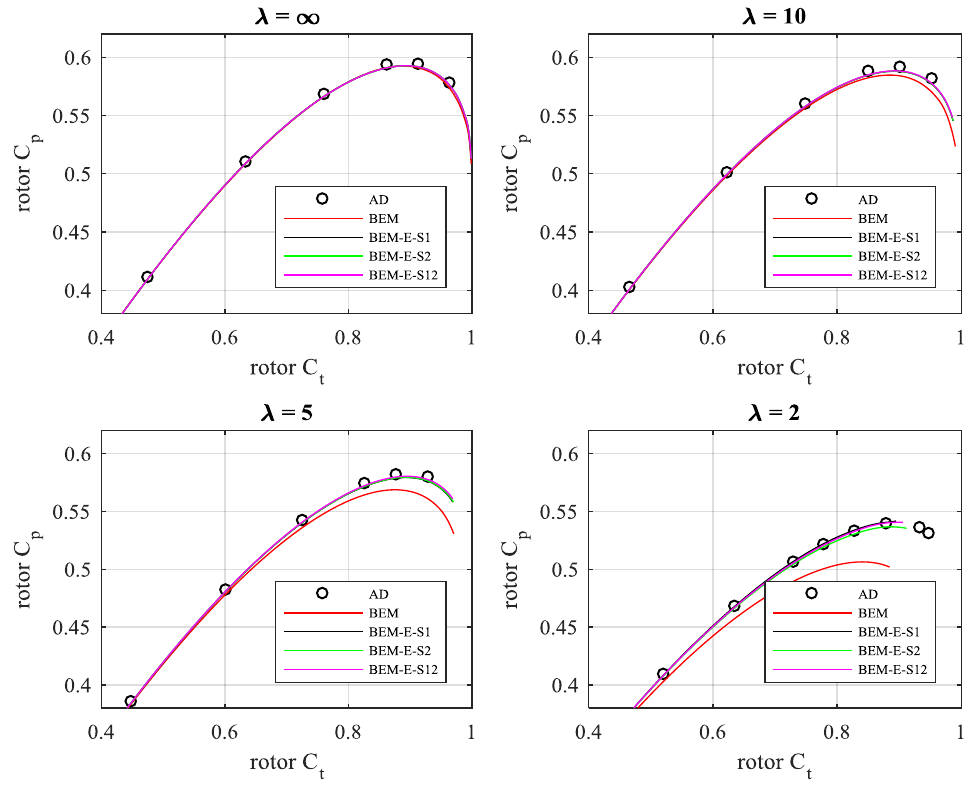
Figure 12. Rotor power coefficient versus rotor thrust coefficient for different tip-speed ratio λ .